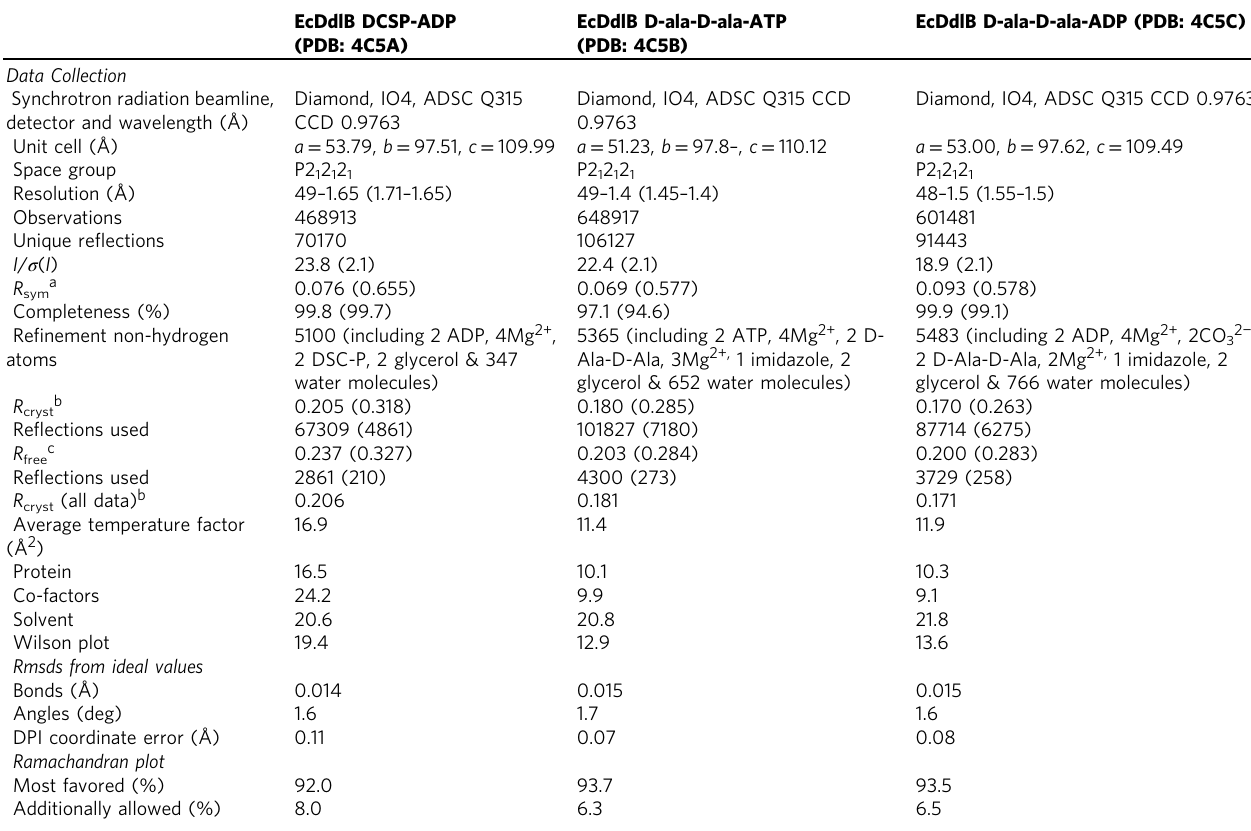
Table 1 Data collection and re fi nement